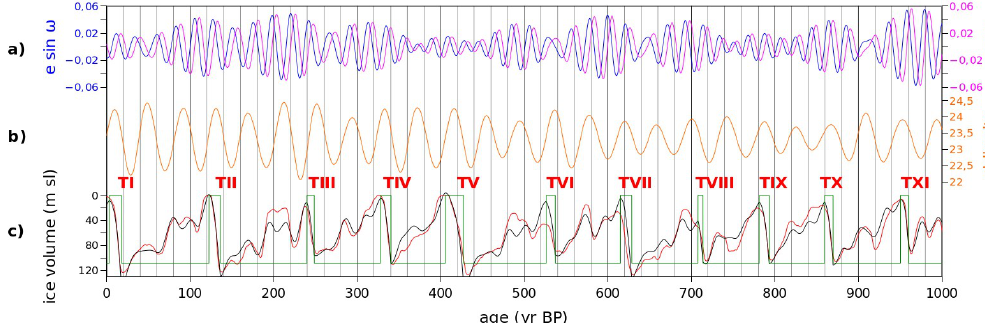
Fig. 1. Model orbital forcings (Laskar et al., 2004), ice volume data (Bintanja et al., 2005), and model experiments. Terminations are marked with red roman numbers. From top to bottom: (a) precession parameters e sin ω and e cos ω . (b) Obliquity parameter. (c) Red: ice volume data; Black: optimized model experiment Best; Green: model state.